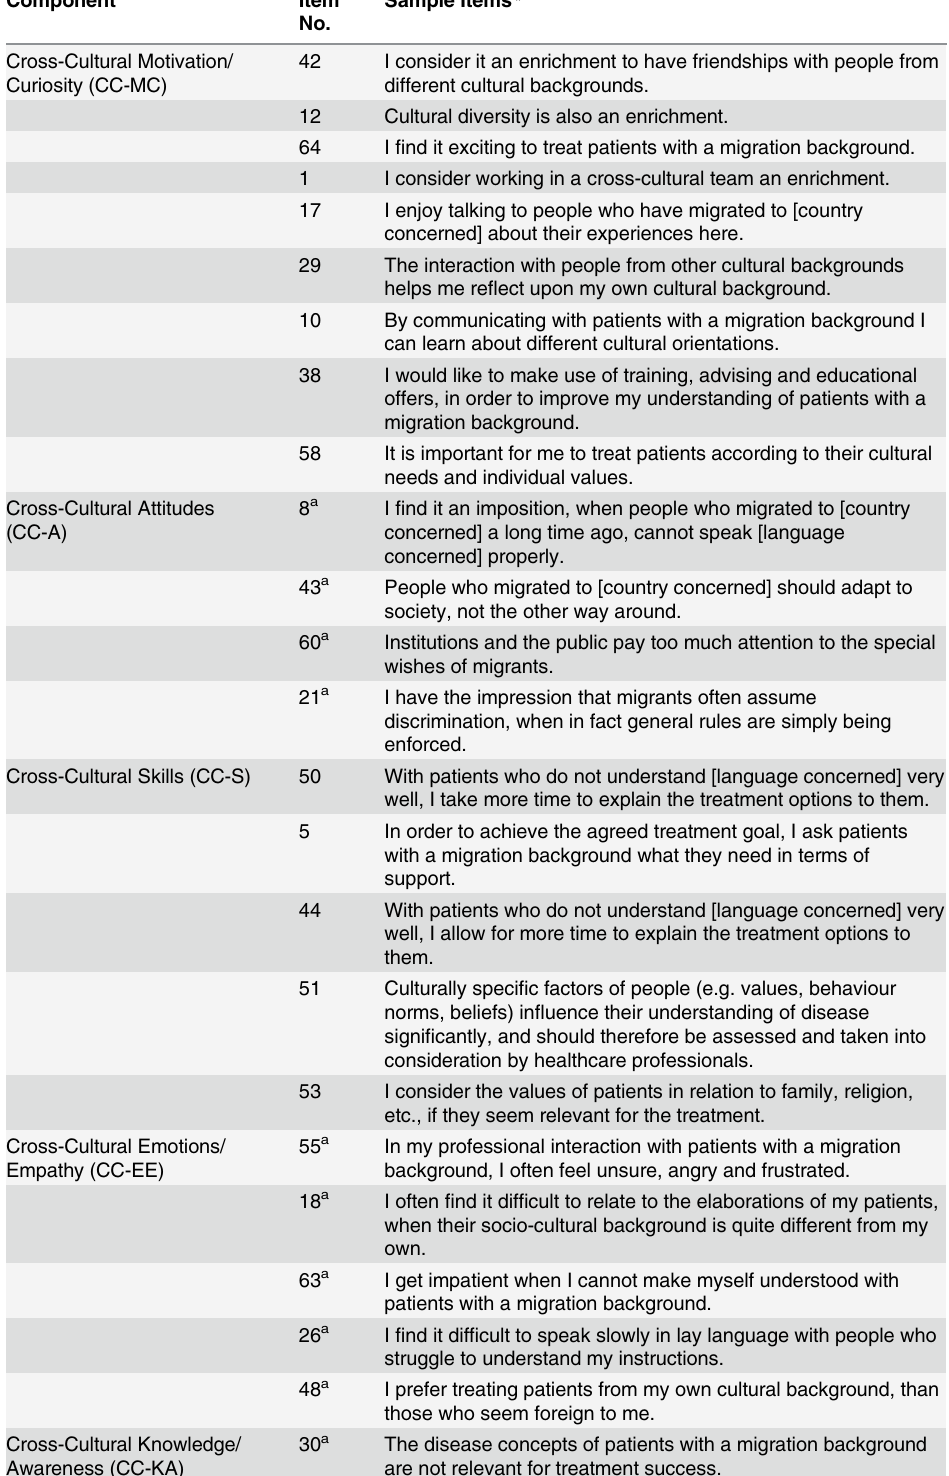
Table 3. Components of the CCCHP-27 with corresponding items ( English